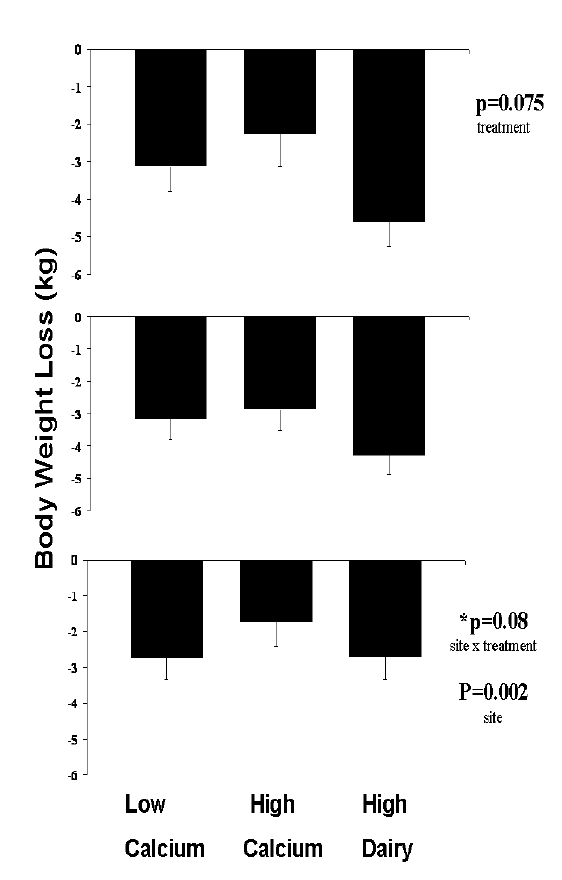
Figure 3. Effects of dietary treatments on weight loss. Top panel: Adherent subjects. Middle panel: All subjects completing the study. Bottom panel: Intent-to-treat analysis. All data are presented as mean ± standard